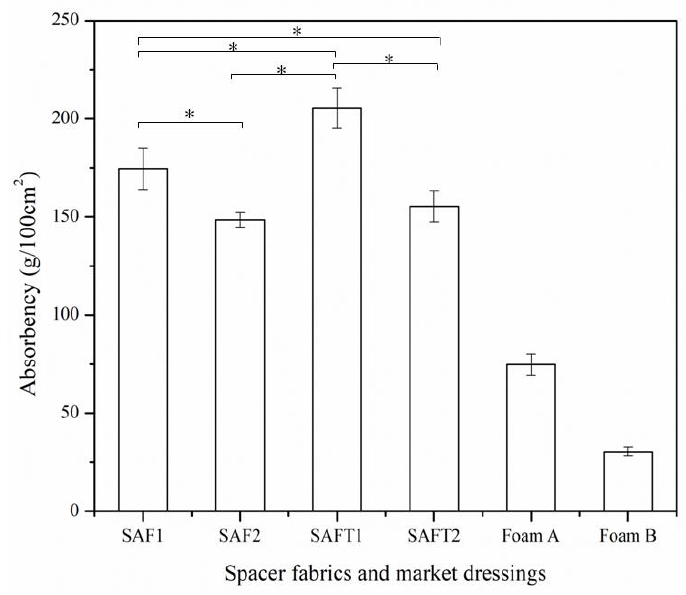
Figure 6. Absorbency of the spacer fabrics and foam dressings from the market. * p < 0.05.